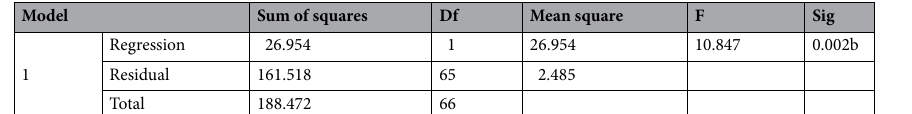
Model Sum of squares Df Mean